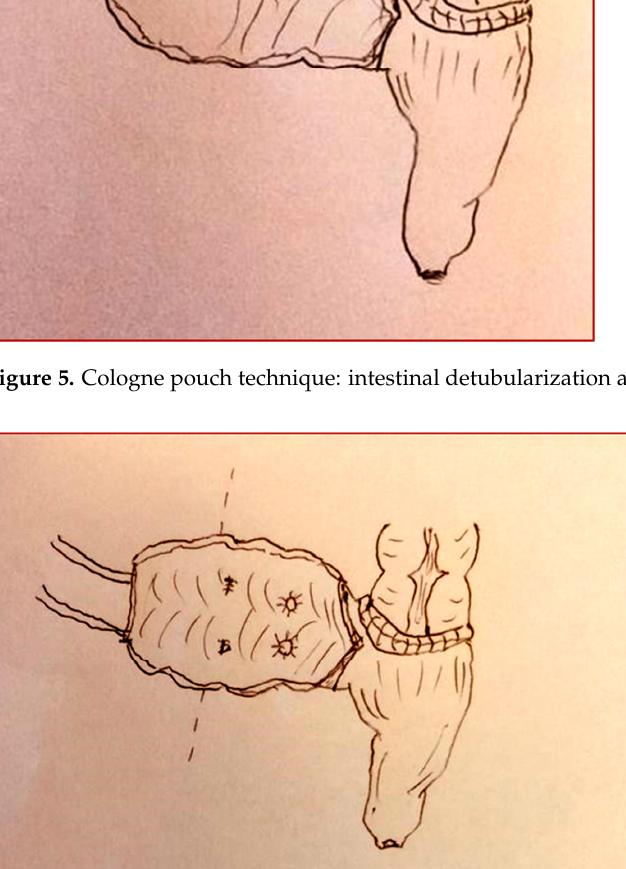
Figure 7. Cologne pouch technique: creation of the pouch. At 12 years of age, during follow-up, the patient did not present long-term compli- cations. Urinary continence was good, with a neo-bladder emptying nearly every 2–3 h (Figure 8A,B). The patient is clean during the day and she presents a good quality of life.